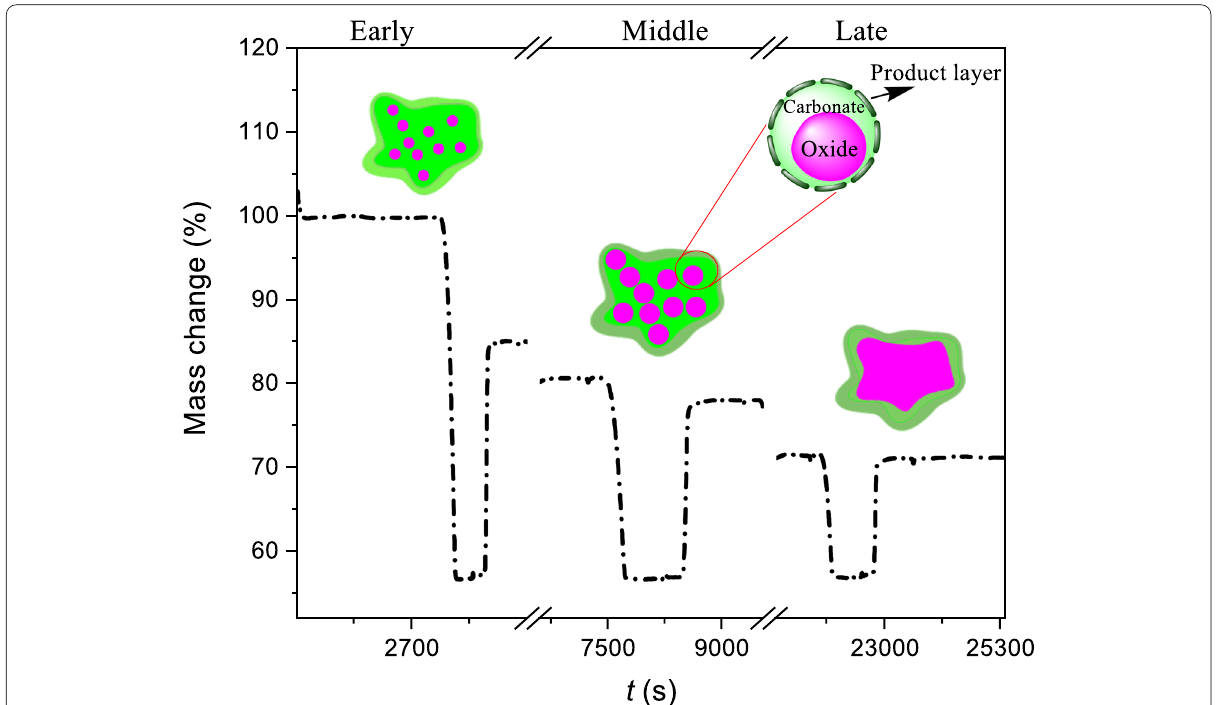
Fig. 11 Illustration for AEMOs cyclic decay with carbonation and calcination curves as recorded in a TGA [49,